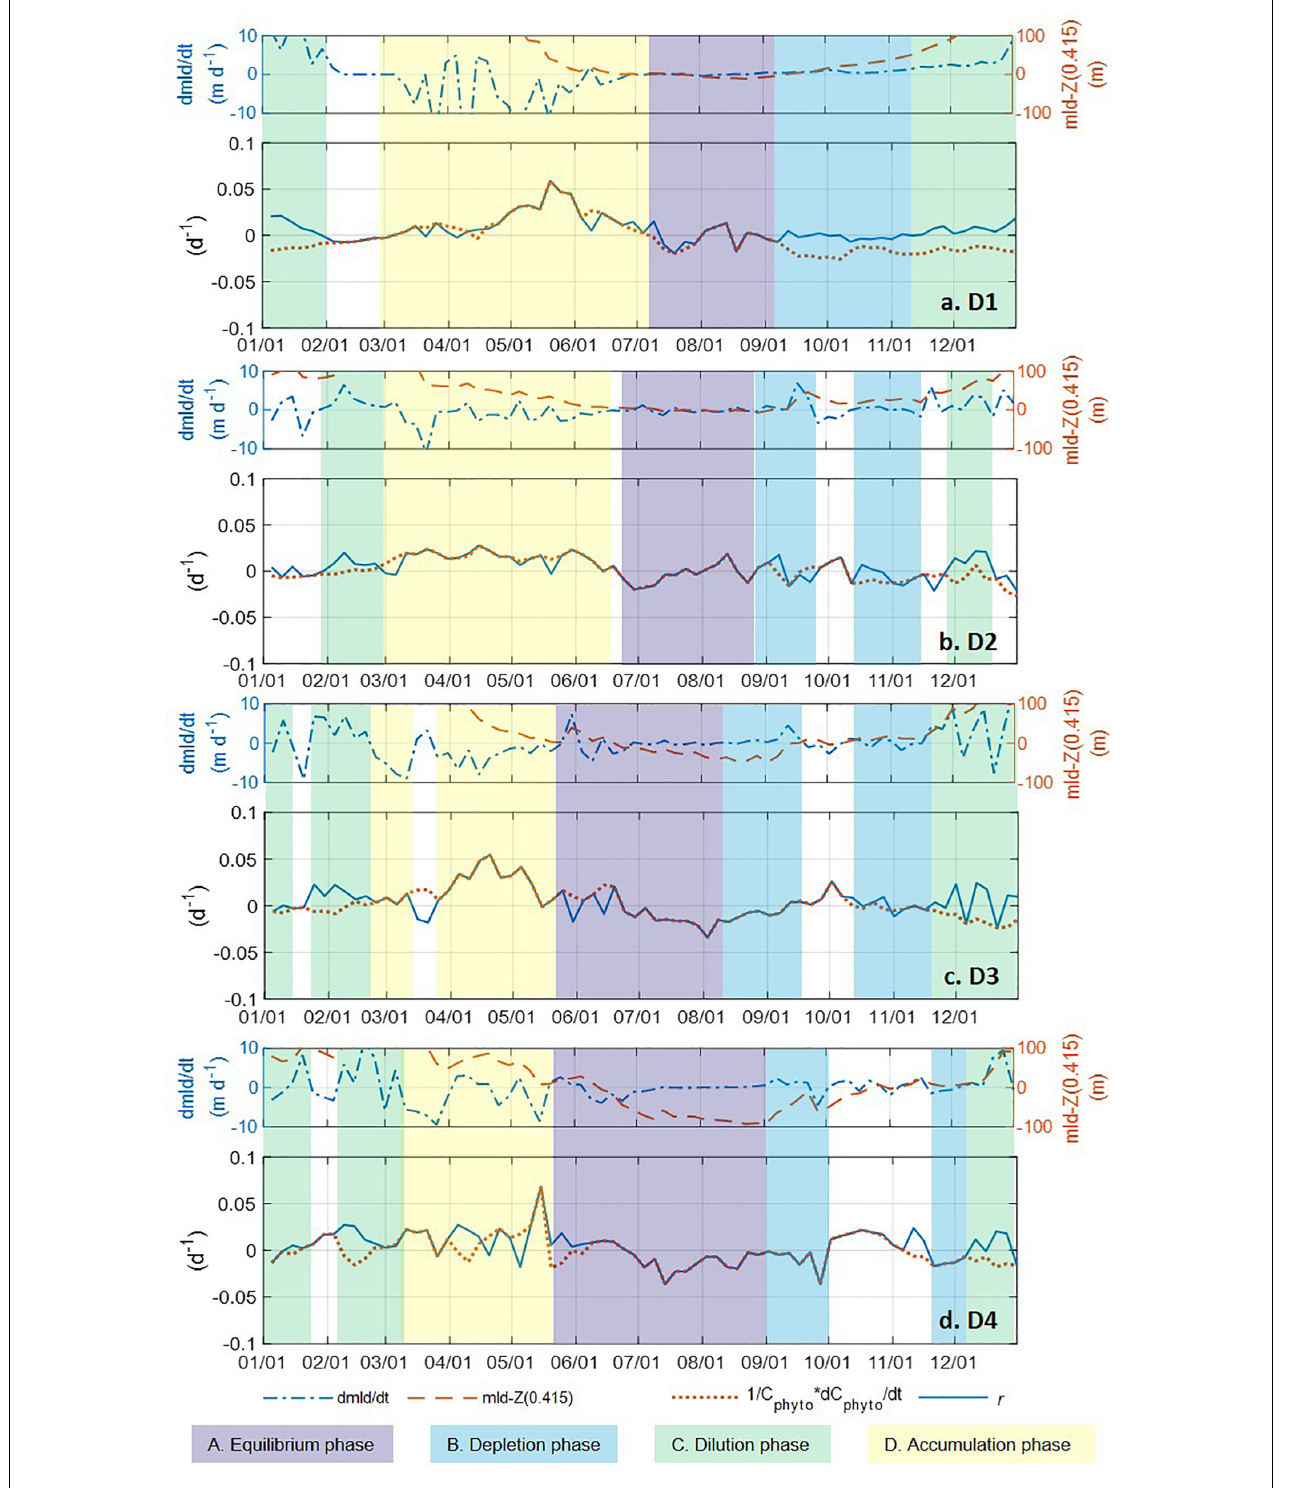
FIGURE 7 | The time rate of change in MLD (d MLD /dt, blue dash-dotted line), difference between MLD and Z(0.415) (red dashed line), time rate of change in normalized C phyto (1/ C phyto *d C phyto /dt, red dotted line), and phytoplankton net accumulation rate r (blue solid line) in the mixed layer from biogeochemical Argo float measurements (panels A–D represent regions D1–D4). A five-point moving mean was applied to all three parameters. The color shadings represent the four phases of the seasonal phytoplankton biomass dynamics described by the “Disturbance and Recovery Hypothesis (DRH)”. Periods with phytoplankton phenology that did not have all the characteristics matching any DRH phase were left blank, without any color shading.